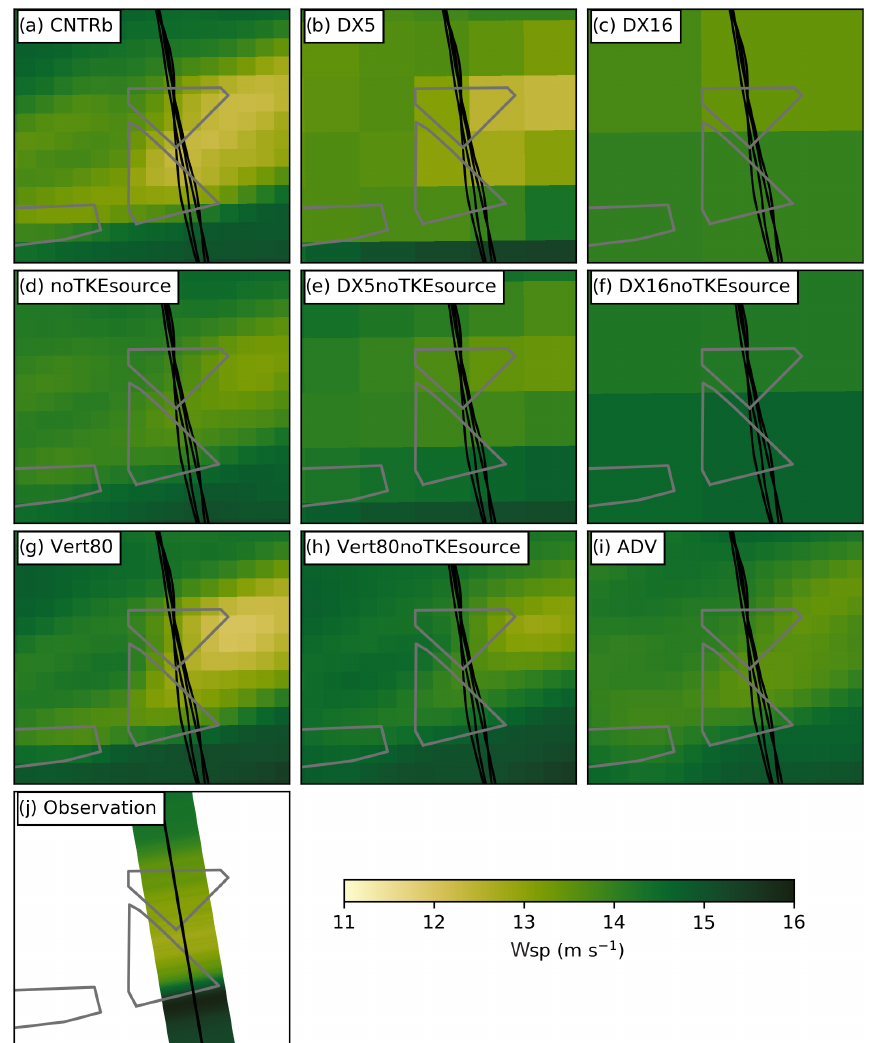
Figure 13. As in Fig. 7 but for the sensitivity simulations (b–i) DX5, DX16, noTKEsource, DX5noTKEsource, DX16noTKEsource, Vert80, Vert80noTKEsource and ADV at 15:00UTC. A summary of all sensitivity tests is listed in Table 2. For better comparison, the control simulation CNTRb is shown in panel (a) and the observations in (j)